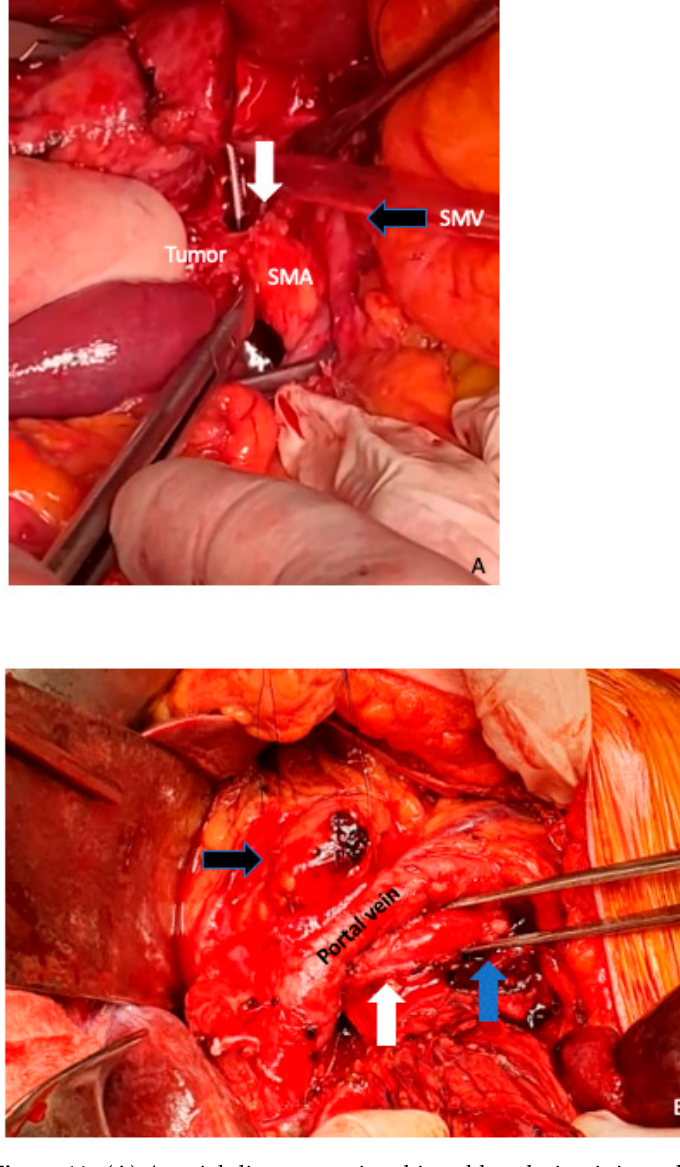
Figure 11. ( A ) Arterial divestment, is achieved by placing it in a plane between the uninvolved arterial wall and the tumor tissue of the affected arterial segment. The dissection plane should be placed between the periarterial nerve plexus and the arterial adventitia. We usually perform this maneuver with cold scissors to avoid thermal damage to the arterial wall, as can be seen in the image. The white arrow shows the limit between the tumor and the superior mesenteric artery (SMA) wall. Black arrow, retracted superior mesenteric vein (SMV) ( B ) The white arrow is showing the tunica adventitia of the superior mesenteric artery, which has then been removed distally, to give a tumor margin: the tunica media of the superior mesenteric artery can be seen at the level of the forceps and marked with a blue arrow. Pancreas stump (black arrow).